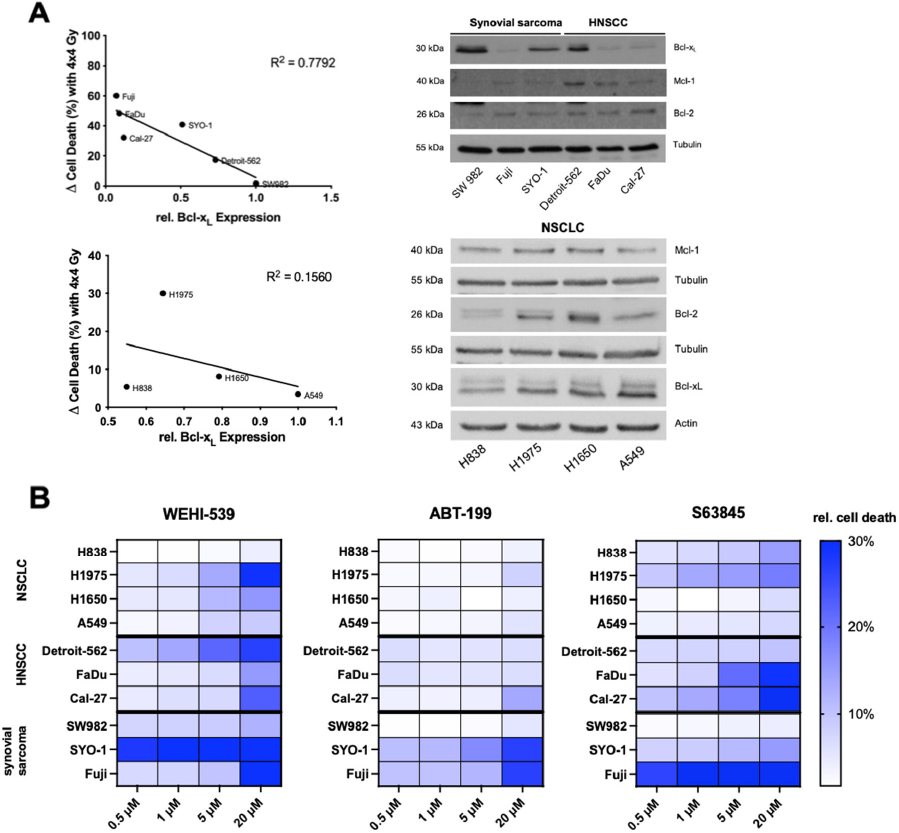
Figure 2. Correlation of relative Bcl-x L expression with radiation induced cell death. ( A ) The coefficient of determination (R 2 ) was calculated by plotting the results of a densitometric analysis of shown Western blots against radiation-induced cell death at delta 4 × 4 Gy. Representative Western blots; Tubulin/Actin served as loading control. HNSCC and synovial sarcoma cell lines were grouped together due to their similar reaction to radiation with Bcl-x L upregulation. ( B ) Graphical depiction via heatmap of inhibitor-induced cell death. FACS analysis of cell death induction during treatment with BH3 mimetics in different concentrations. Experiments were performed in triplicate and cell death was measured as mean ± SD. Findings are depicted graphically in a heat map for overview purposes. Results are representative of at least three independent